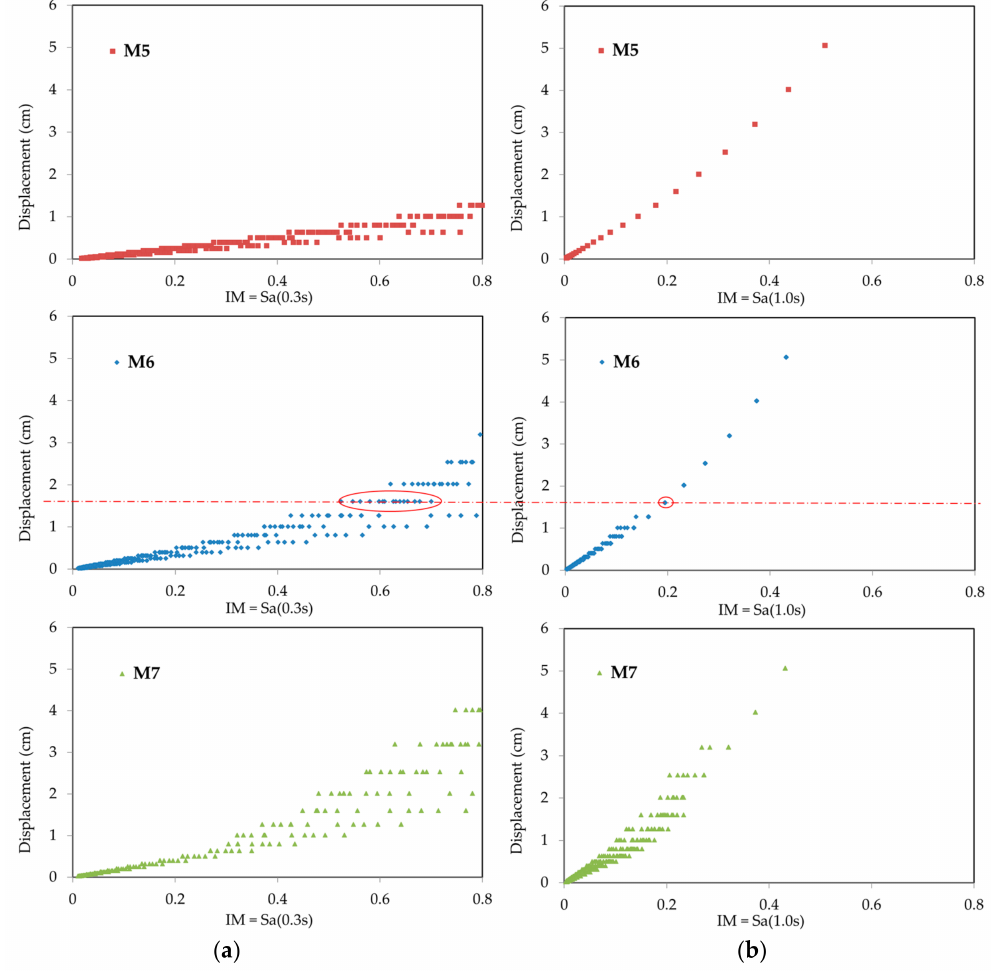
Figure 3. Variation of the displacement demand at the performance point for low-rise pre-code unreinforced masonry building (URML-p) for M5, M6 and M7 and all distances and site classes applying ( a ) Sa(0.3s) as intensity measure and ( b ) Sa(1.0s) as intensity